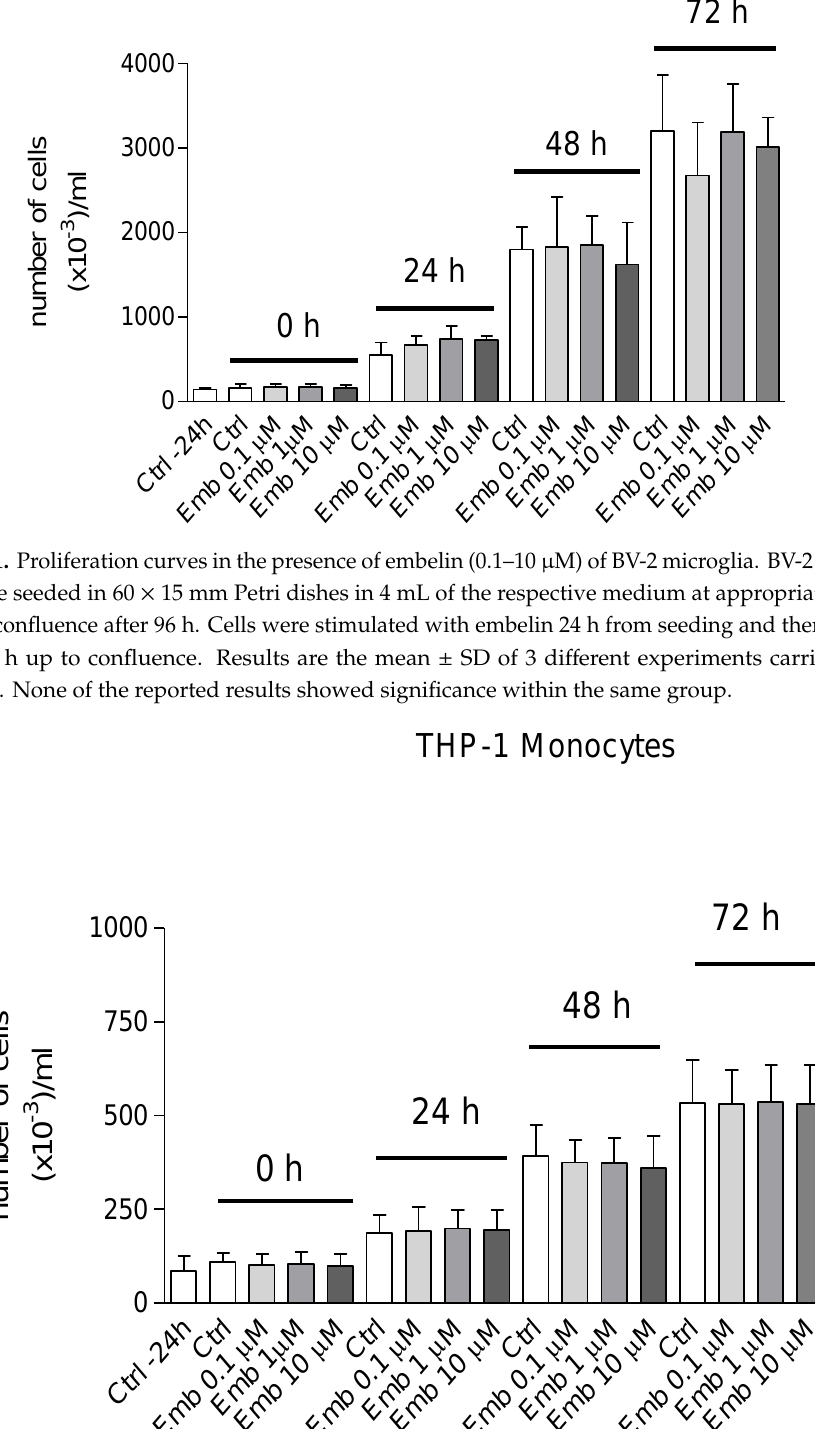
Figure 22. Proliferation curves in the presence of embelin (0.1–10 µ M) of THP-1 human leukemic monocytes. The THP-1 monocytes growing in suspension were seeded in 24 wells plates with 1 mL complete medium. Cells were stimulated with embelin 24 h from seeding and then counted every 24 h up to optimal density (96 h). Results are the mean ± SD of 3 di ff erent experiments carried out in triplicate. None of the reported results showed significance within the same